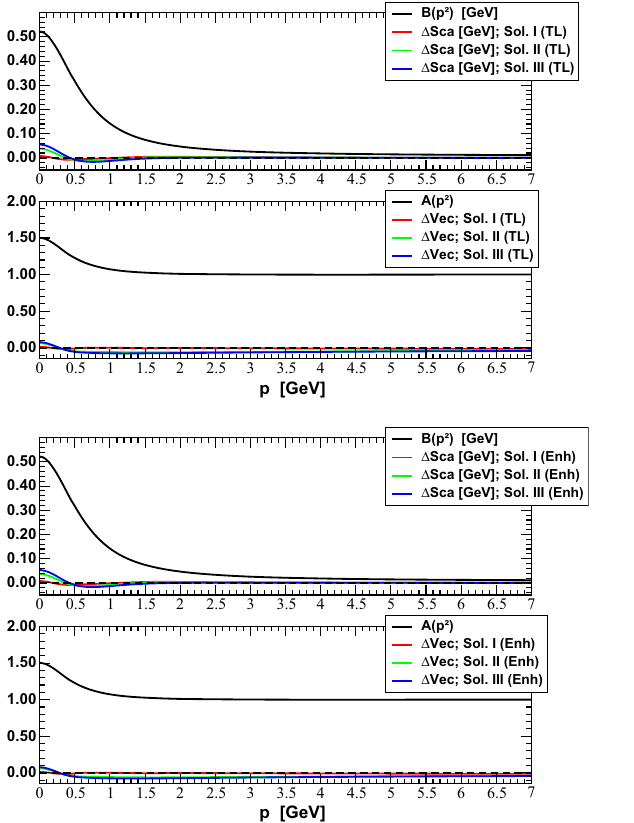
Fig. 15 Relative error on the solution of the Scalar (top) and Vector (bottom) Dyson–Schwinger equation when using the tree level ghost- gluon vertex (top) and the enhanced gluon-ghost vertex